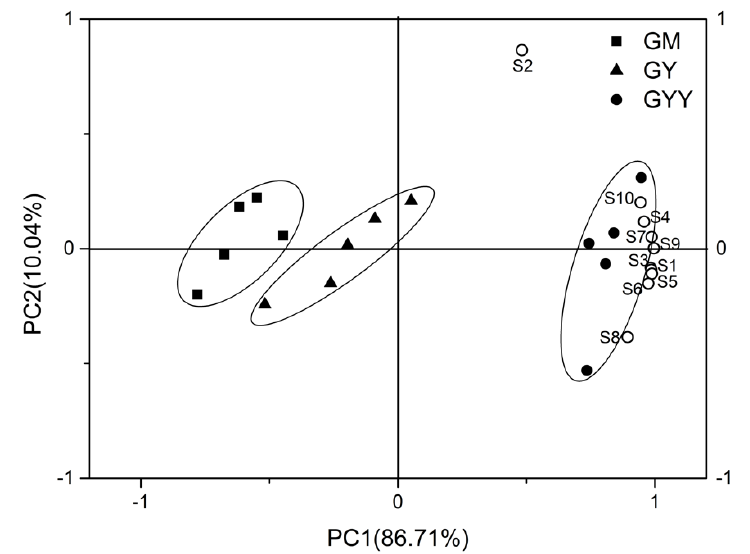
Figure 5. Principal component (PC) analysis of E-nose data set in response to aroma compounds generated from various groups of goat milk samples.